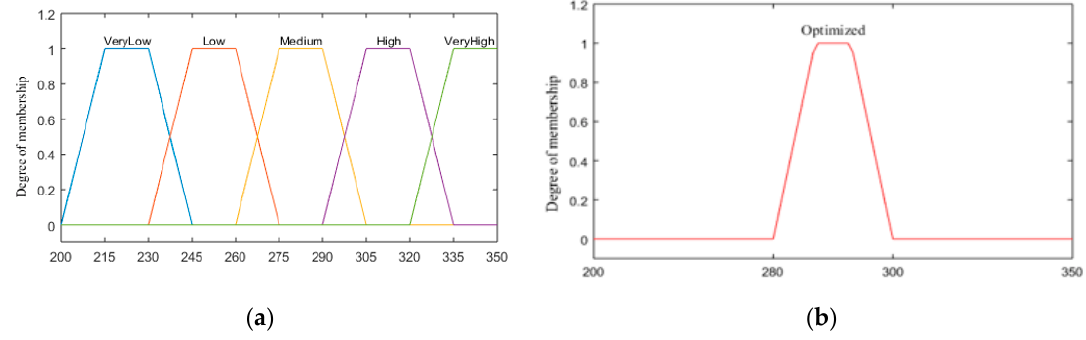
Figure 5. Membership function graphs for water level (mm). ( a ) Current waterlevel. ( b ) Optimized water level.